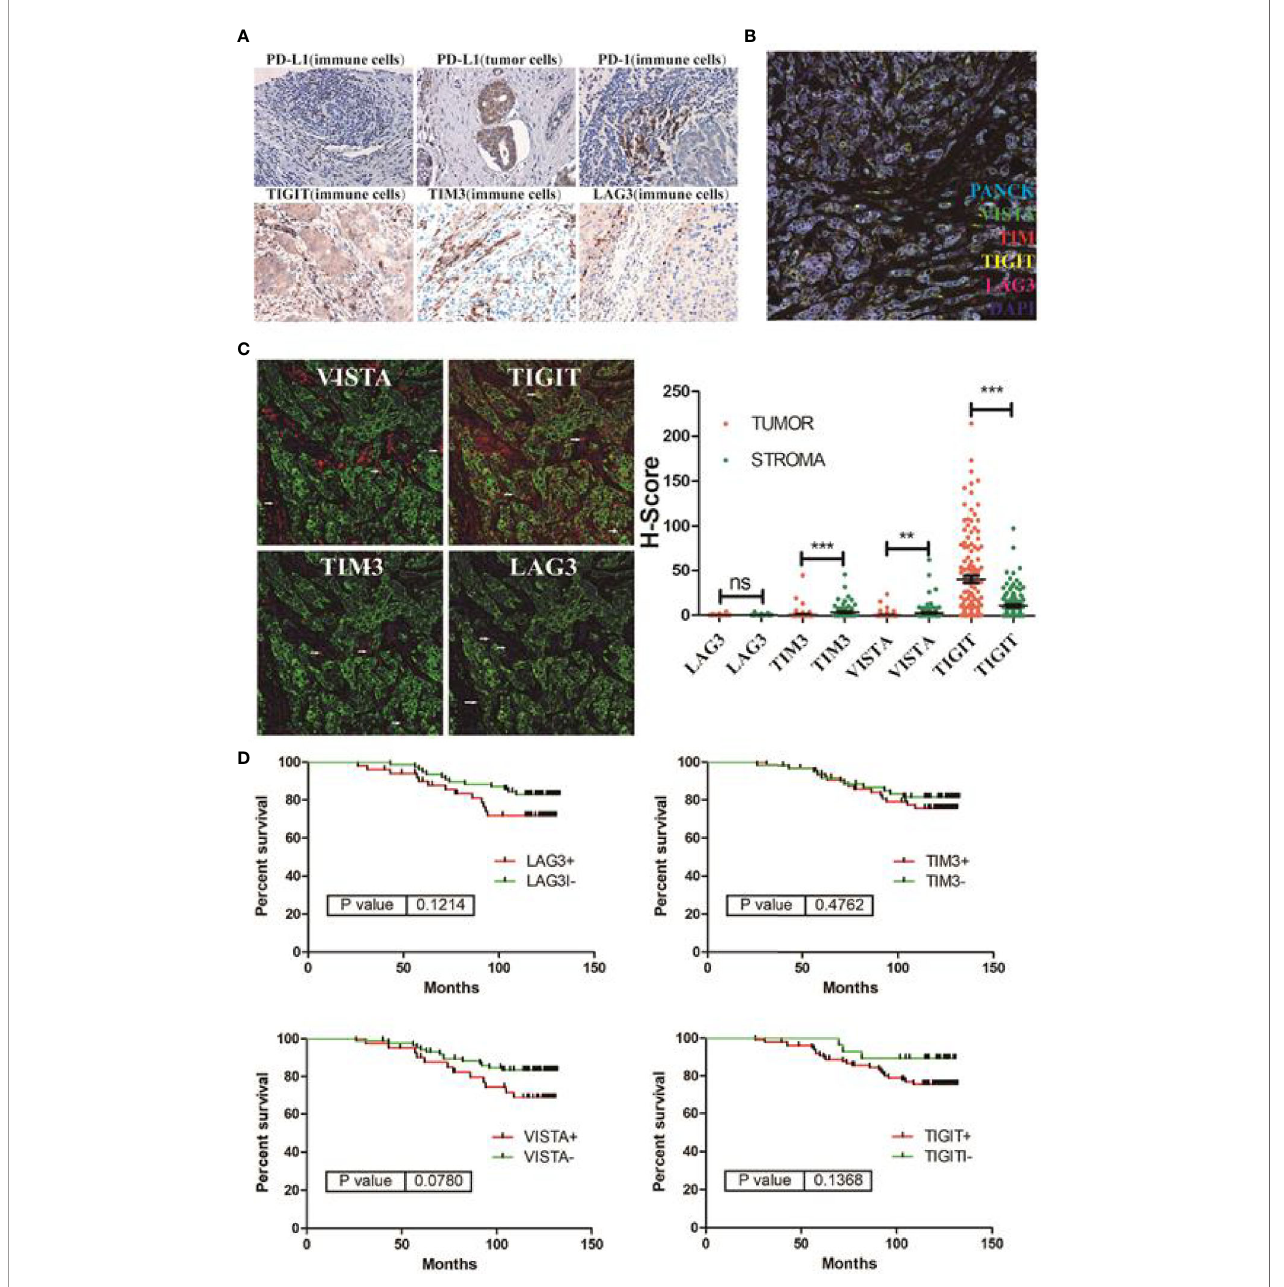
FIGURE 5 | (A) Representative immunohistochemical staining for immune checkpoint molecules (PD-L1, PD-1, TIGIT, TIM3 and LAG3) in breast cancer samples. (B) Representative multiplex immuno fl uorescence staining for immune checkpoint molecules (VISTA, TIGIT, TIM3 and LAG3) in breast cancer samples. VISTA staining is shown in green; TIGIT staining is shown in yellow; TIM3 staining is shown in red; LAG3 staining is shown in magenta; PANCK staining is shown in cyan; and DAPI staining is shown in blue. (C) Co-localization of PANCK with VISTA, TIGIT, TIM3 and LAG3 in breast cancer detected by immuno fl uorescence. VISTA, TIGIT, TIM3, LAG3 staining is shown in red; PANCK staining is shown in green; and DAPI staining is shown in blue. (D) Kaplan-Meier curves showing overall survival (OS) of breast cancer patients based on immune-checkpoints (VISTA, TIGIT, TIM3 and LAG3) status. ** p < 0.01, *** p < 0.001. NS, no signi fi